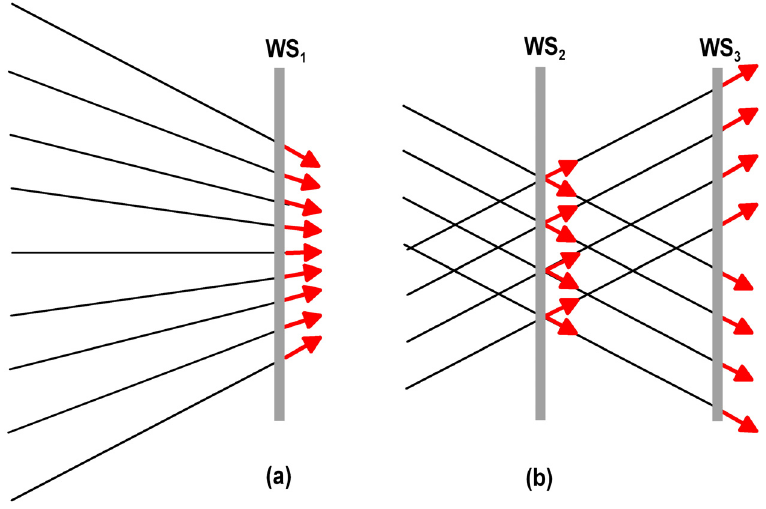
Figure 1. Ambiguity of local wavefronts of nondiffracting beams in comparison to a convergent beam (simplified ray representation): ( a ) Gaussian-type beam with unambiguous Poynting vectors (red arrows) as detected by a Shack-Hartmann wavefront (gray); ( b ) Bessel beam with an ambiguity in the sensor at a certain plane WS 1 superposition zone WS (gray) and a ring-shaped unambiguous angular distribution at a 2 behind the superposition zone (gray). Linear light bullets in absence of a distance WS 3 medium are created by constructive interference in superposition zones like shown in ( b